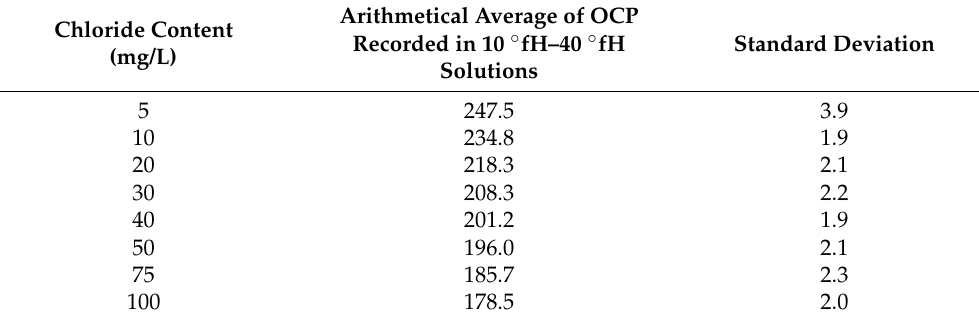
Table 3. Arithmetical average and standard deviation values of the OCP response recorded for a certain chloride concentration (5–100 mg/L) in solutions with different hardness levels (10 ◦ fH–40 ◦ fH) (see Table 2).